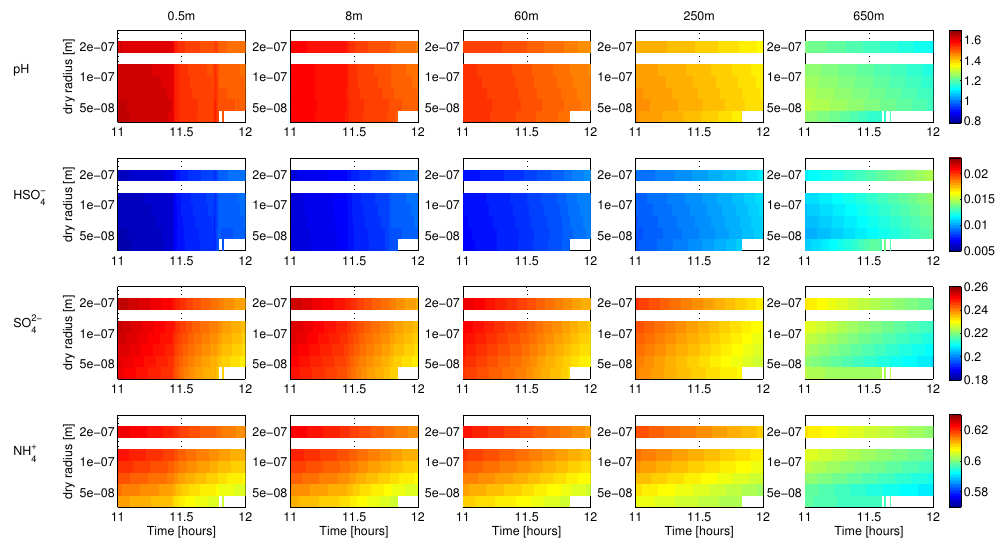
Fig. 7. Non-seasalt compositional data at different levels through the model column for the base case, low tide, model run. First row is pH. Second, third and fourth rows are HSO −